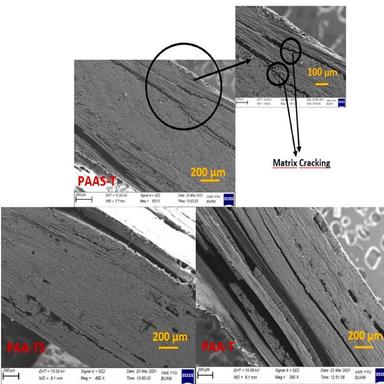
The SEM images of PAAS-T, PAA-TS and PAA-T after the flexural Test.